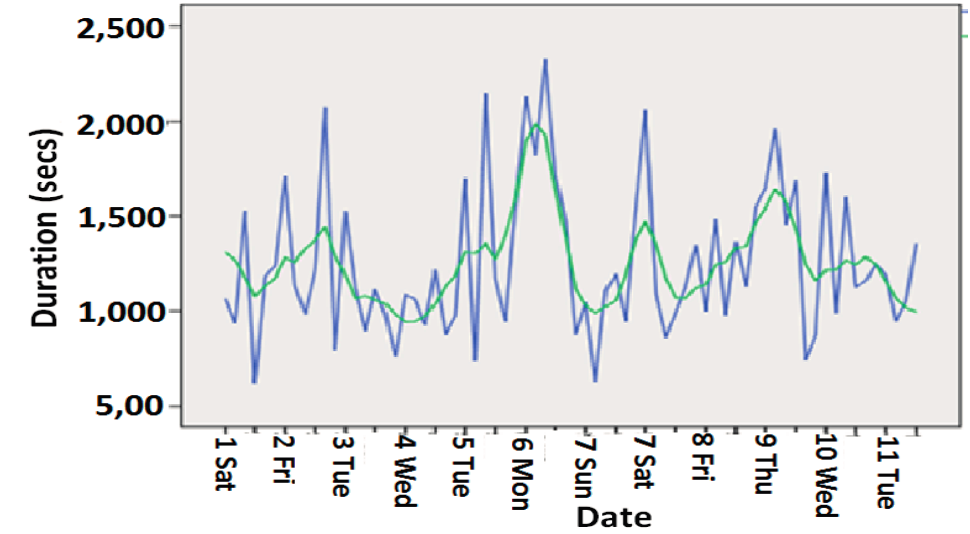
Figure 11. Dining chair usage activity durations